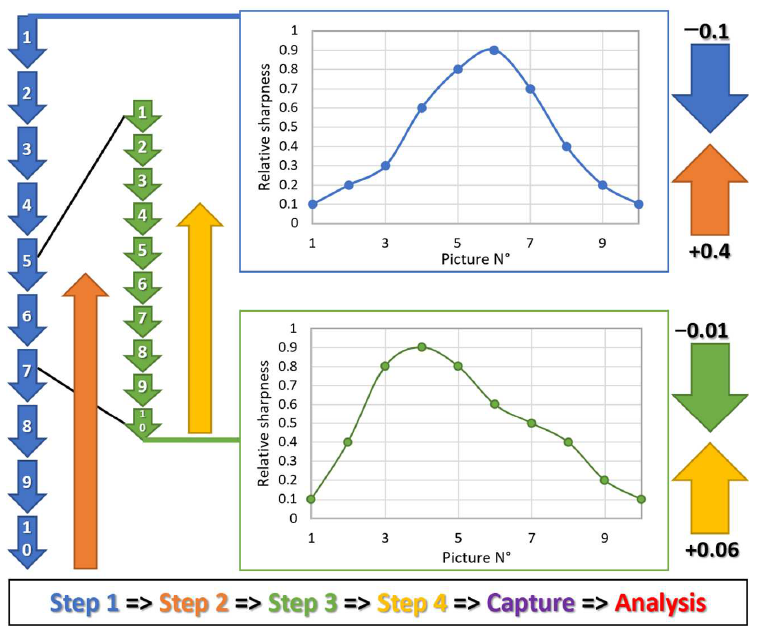
Figure 7. Autofocus. The autofocus procedure consists in measuring the sharpness of 20 images captured at different heights to determine the optimal camera positioning. The arrows schematize the vertical movement of the camera (in mm) while the plot represents the “relative sharpness” of the capture returned by the OpenCV Laplacian function.